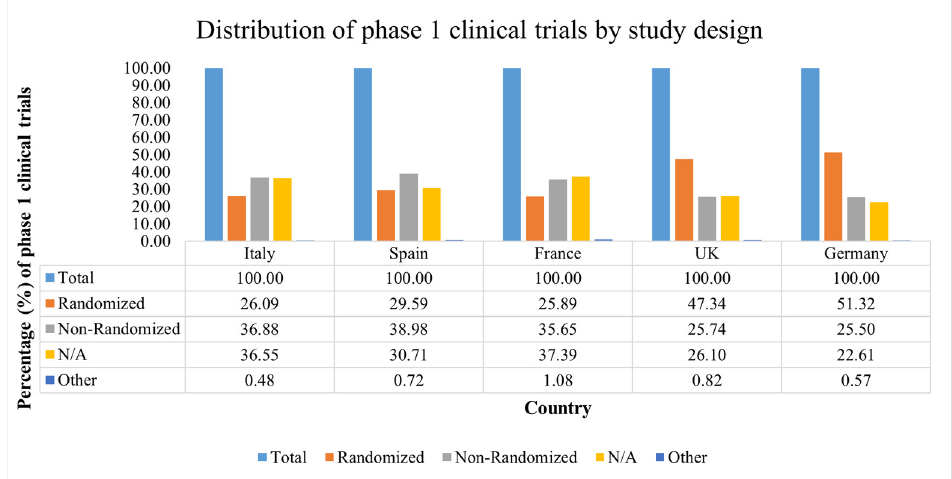
Figure 3. Distribution of phase 1 clinical trials by study design. The total number of registered phase 1 clinical trials on ClinicalTrials.gov was divided by country and study design. Five European countries were selected: France, Germany, Italy, Spain and the UK. The period from 1 January 2012 to 31 December 2021 was taken into consideration.